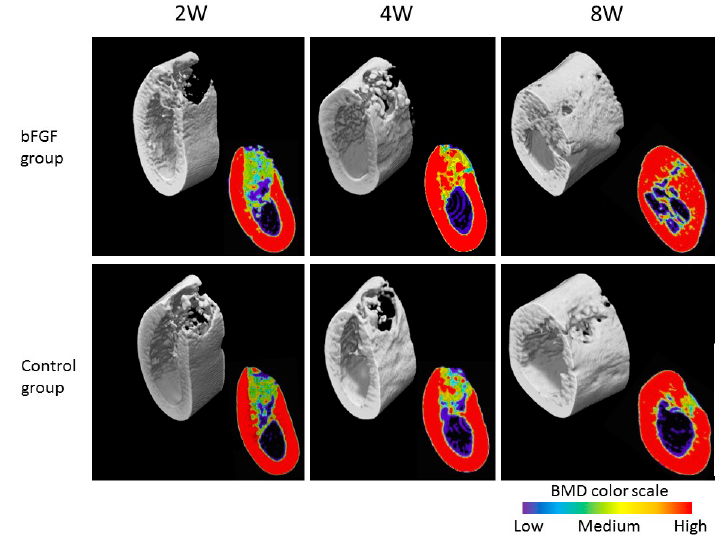
Figure 3. Three-dimensional images and bone mineral density (BMD) analysis of filled defects in the bFGF and control groups at two, four and eight weeks.